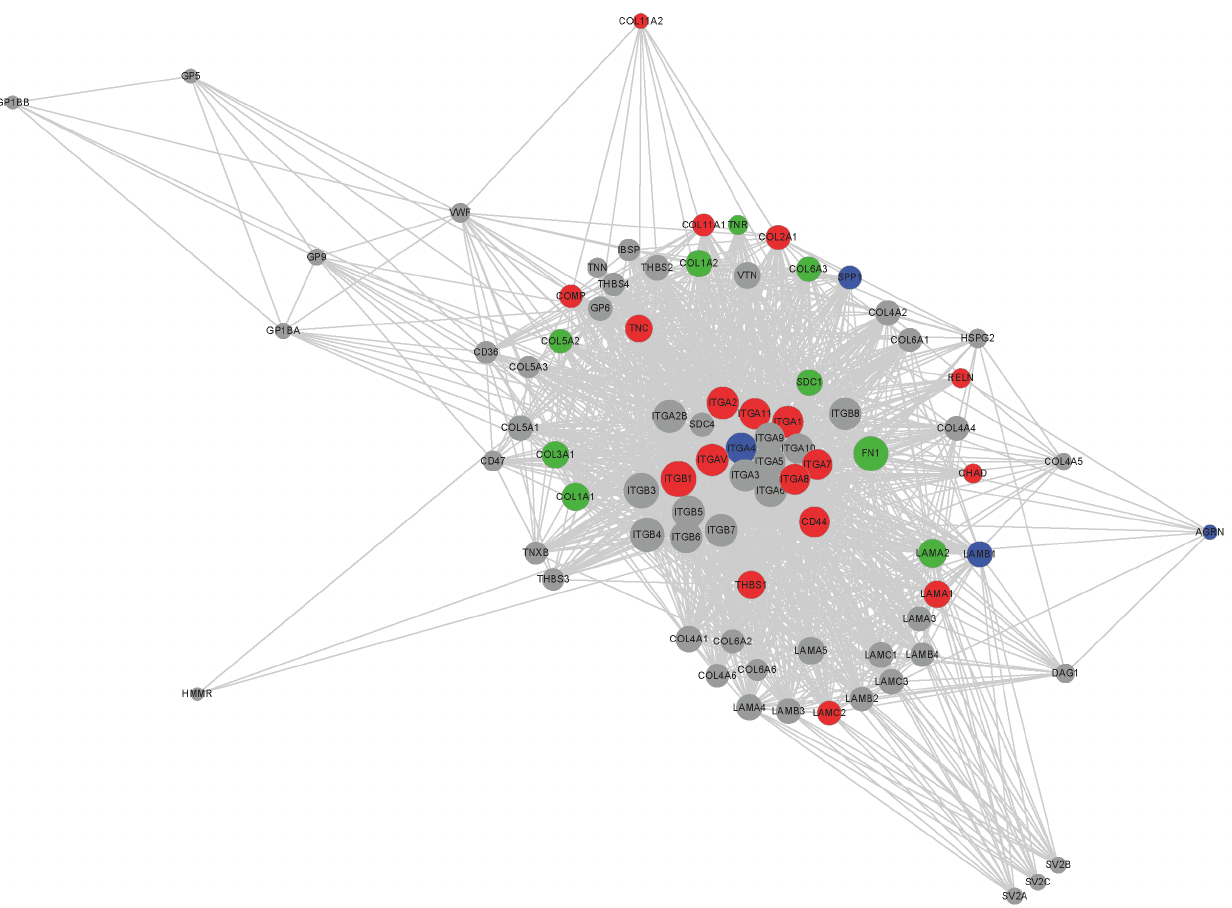
Figure 5. Visualization of molecular network in the KEGG pathway of ECM-receptor interaction using cytoscape. Grey circles represent genes involved in the pathway and the color of the circle represent genes highly expressed in each depot (red:intramuscular, blue: omental, green: subcutaneous). Figure 4), where DEGs in pathways of lipid metabolisms such as PPAR signaling pathways and fatty acid metabolism, and of the immune response systems were significantly down regulated.